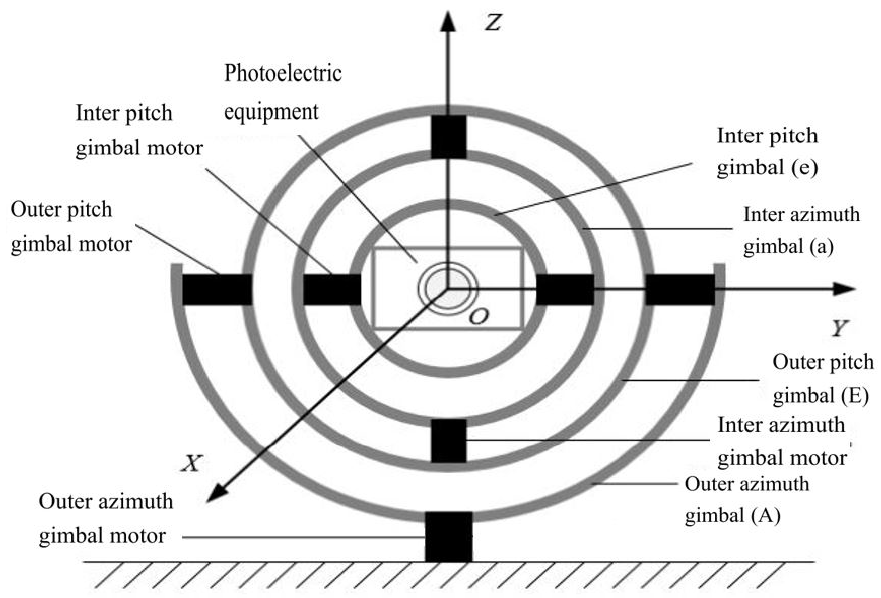
Figure 1. Schematic diagram of two-axis four-frame optoelectronic stabilized platform. The control system consists of current sensor, rate gyro, coder, torque motor, pulse- width modulation (PWM) and controllers. The blocks of G − pos , G − spe and G − cur stand for the controllers in the position loop, stabilization loop and current loop, respectively. The PWM block was used to amplify power to drive the torque motor. Rate gyro and coder were used to measure the angle speed and angle of the frame when it moved. θ in is the input angle, and ω out and θ out are the output angle speed and angle of the system, respectively; M f is the friction torque, and M d is other disturbances except friction. The LuGre model is introduced in the next section.